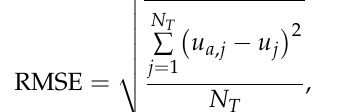
Table 5. RMSE for simulations with different vertical layers and different boundary